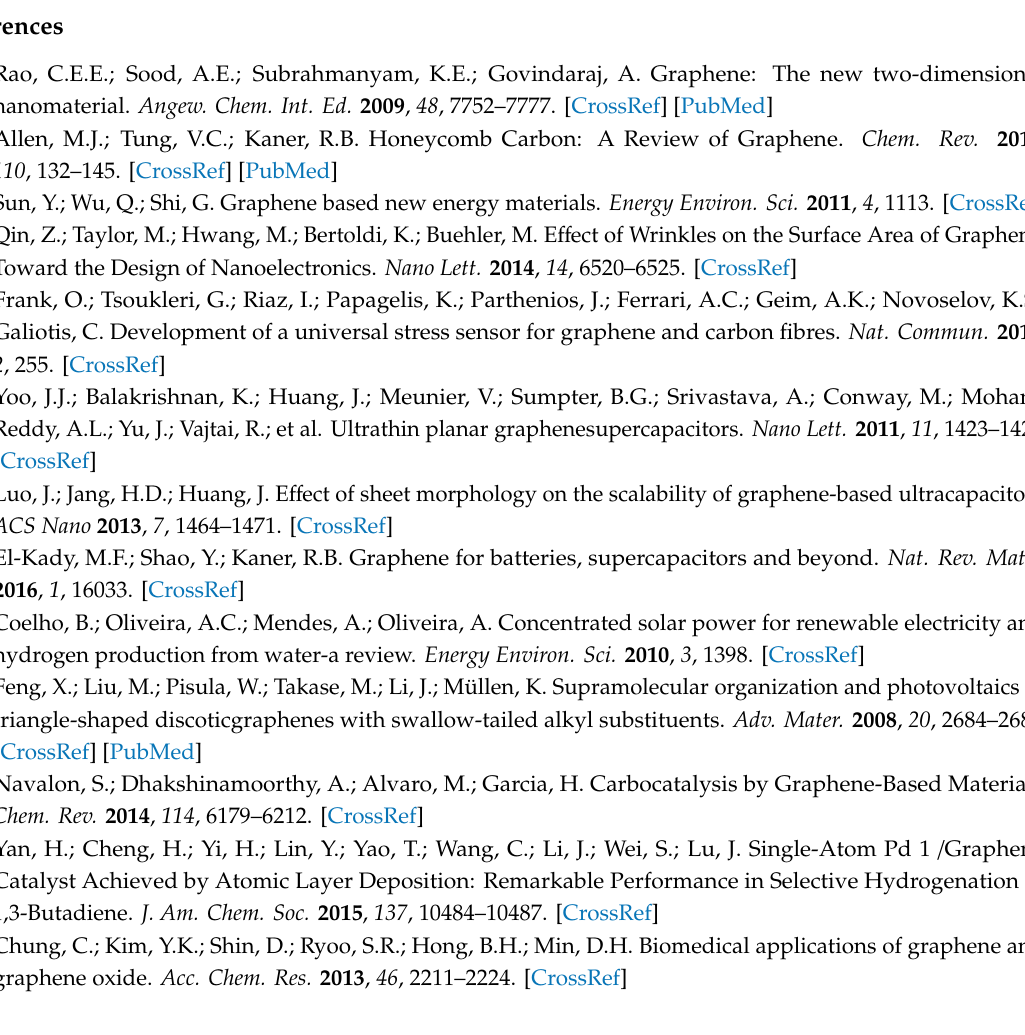
Figure S1: TEM images and Ni / GO-3 with Ni wt% of 15, Figure S2. AFM images of Ni / GO with 15 wt% of Ni (Ni / GO-3); performed directly on the surface of samples and their three-dimensional projections, Figure S3. UV-vis spectra of ( a ) 2-NP and ( b ) 4-NP before and after adding NaBH4